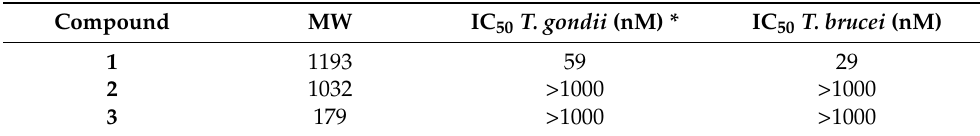
Table 1. IC 50 values of the three compounds used in this